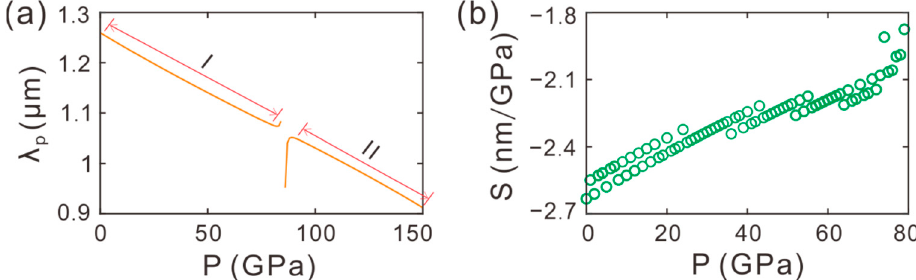
Figure 3. ( a , b ) Central wavelength of the defect mode and sensitivity coefficient of sensors changing with the stationary pressure intensity at the environment temperature Te = 50 K. Periodic number is N = 3.